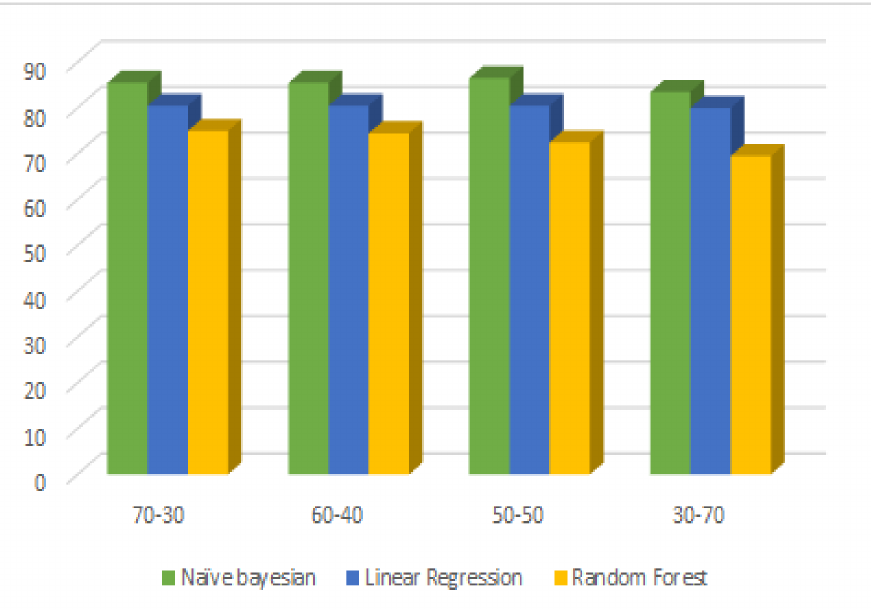
Figure 4. Visualization of F-1 score–based splits of three applied machine learning